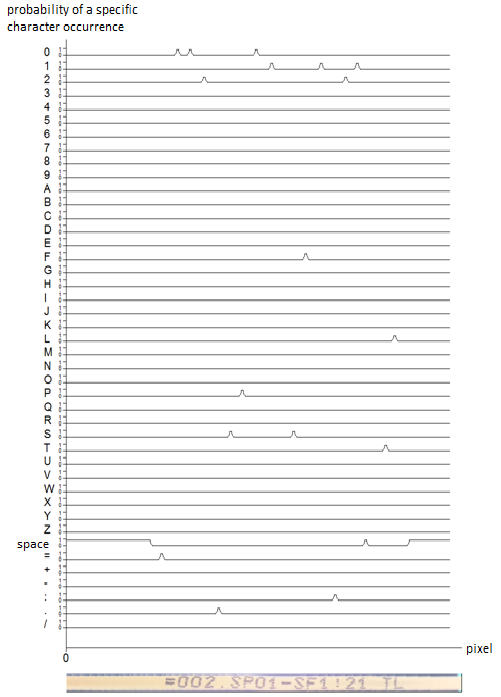
Figure 15. Recognition of the full spectrum of characters during identification of wire marking by using a DCNN.